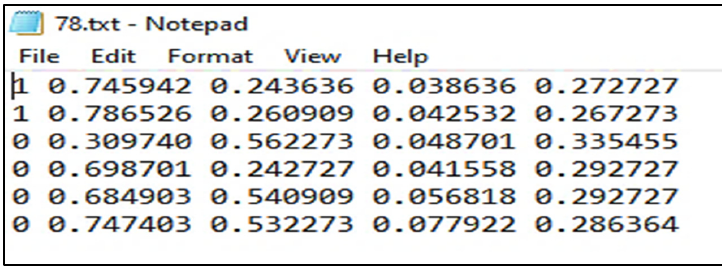
Figure 5. Annotation file in .txt format.